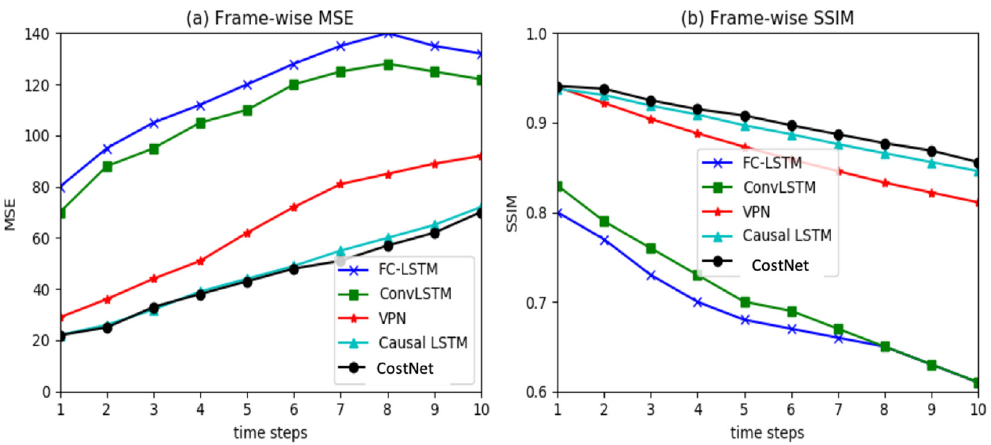
Figure 3. Frame-wise comparisons of different models for predicting 10 frames on the Moving MNIST.